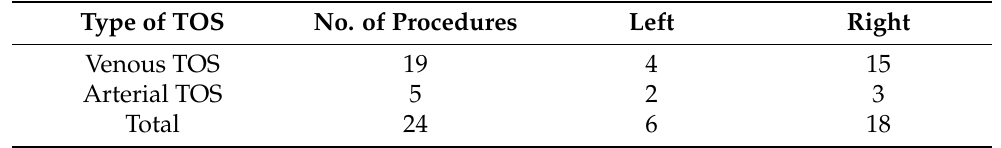
Table 1. Patients with vTOS had predominantly the right side affected.